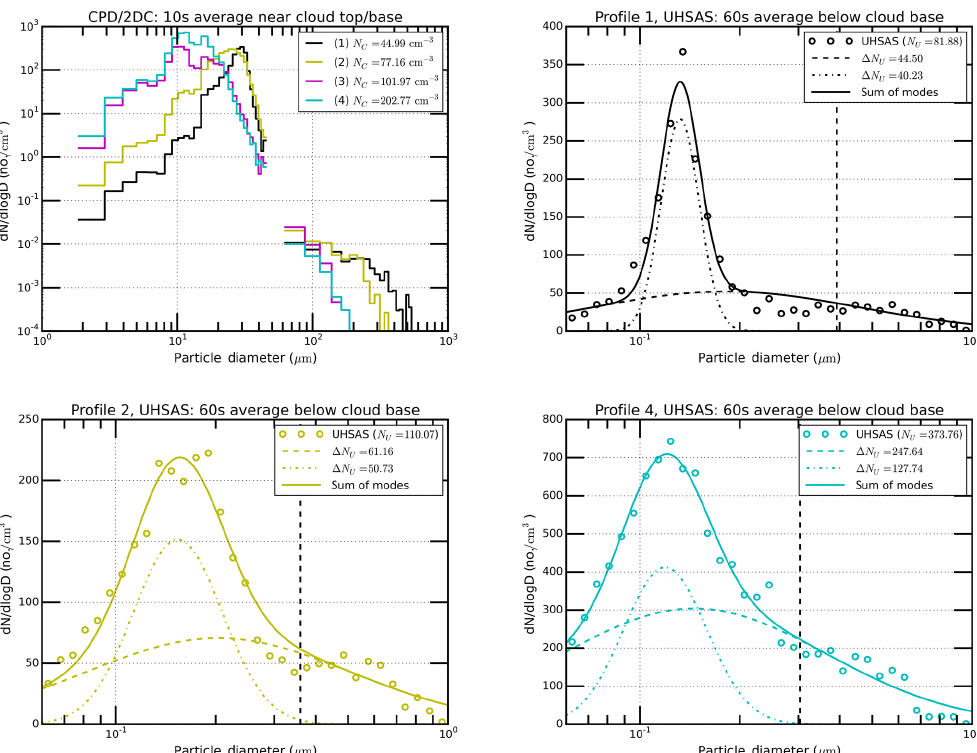
Figure 6. Particle size distributions (PSDs) during HIPPO-4. Upper left panel: 10s average cloud droplet PSDs observed by the CDP near cloud top, and drizzle drop PSDs observed by the 2DC near cloud base. Note the logarithmic y scale for this panel. Upper right, and lower panels: 60s average PSDs for UHSAS data for profiles 1, 2 and 4 as labeled, with fitted modes shown by dashed lines. The contribution to the observed N U for each mode is shown in the legend, and the cutoff size used for identifying the SSA mode marked by a black dashed line (see text). Note the different scales on the y